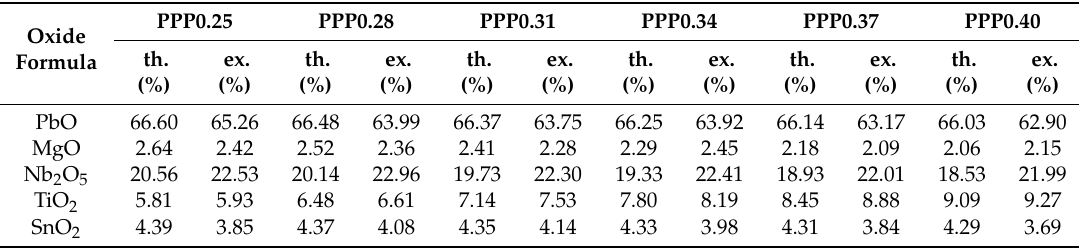
Table 2. Theoretical and experimental percentages of elements (expressed as oxides) of the PMN– PT–PS ceramics. Oxide Formula